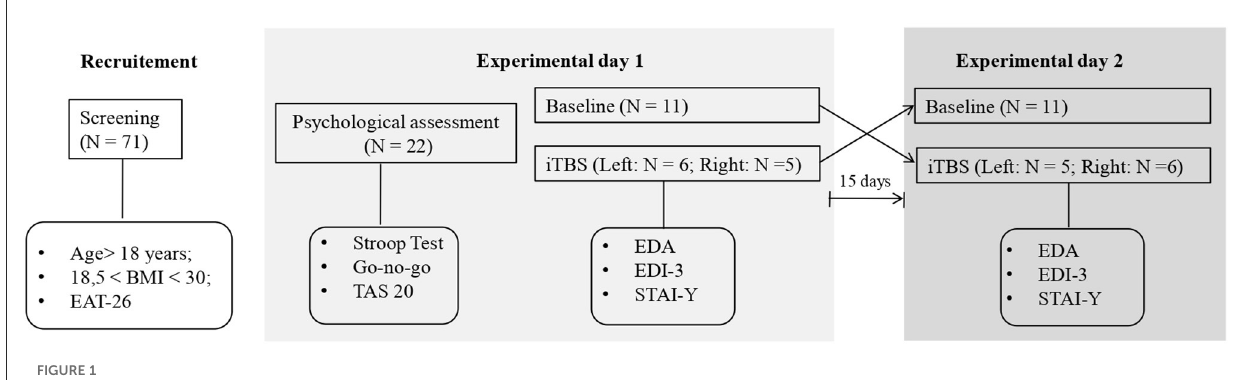
these subscale’s scores was found only when iTBS was applied on the lDLPFC [56, 3 vs. 49,7; p = 0.003, see Figure 2]. A significant interaction between Session X Group was found also in the subscale body dissatisfaction [ F (1, 20) = 7.7, p = 0.01, η p 2 = 0.27]. Again, a significant reduction of this subscale’s scores was found when iTBS was applied to the lDLPFC [56 vs. 52; p = 0.03, see Figure